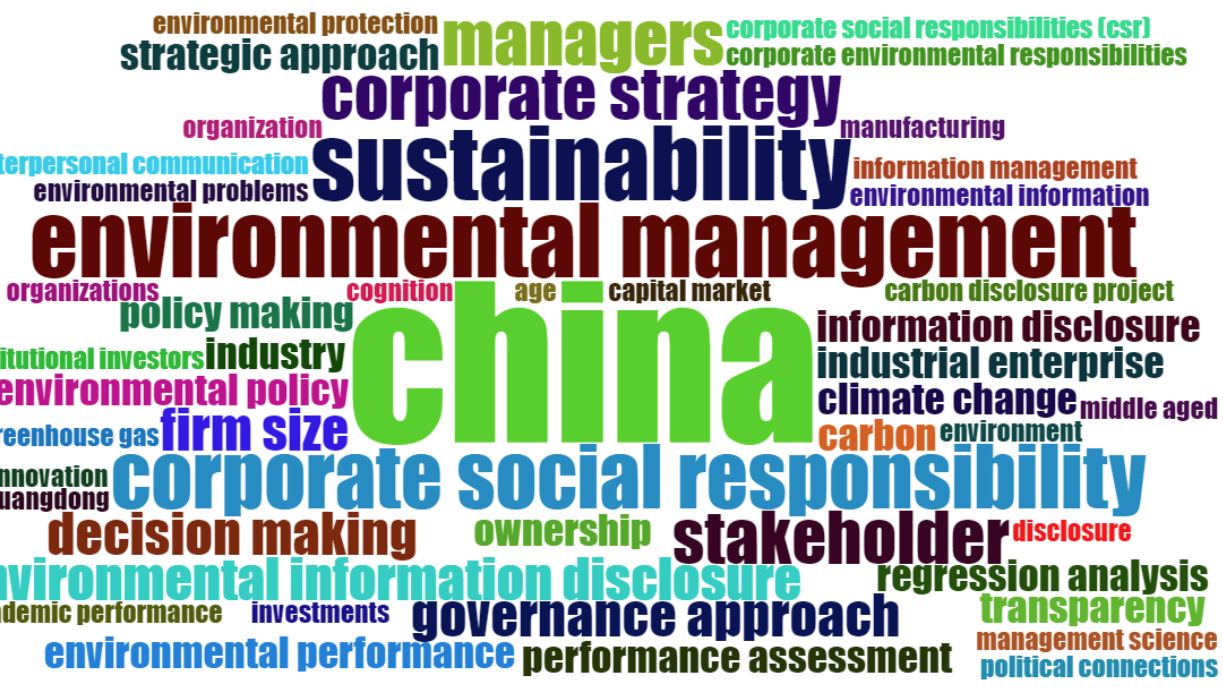
Figure 5. Word Cloud.